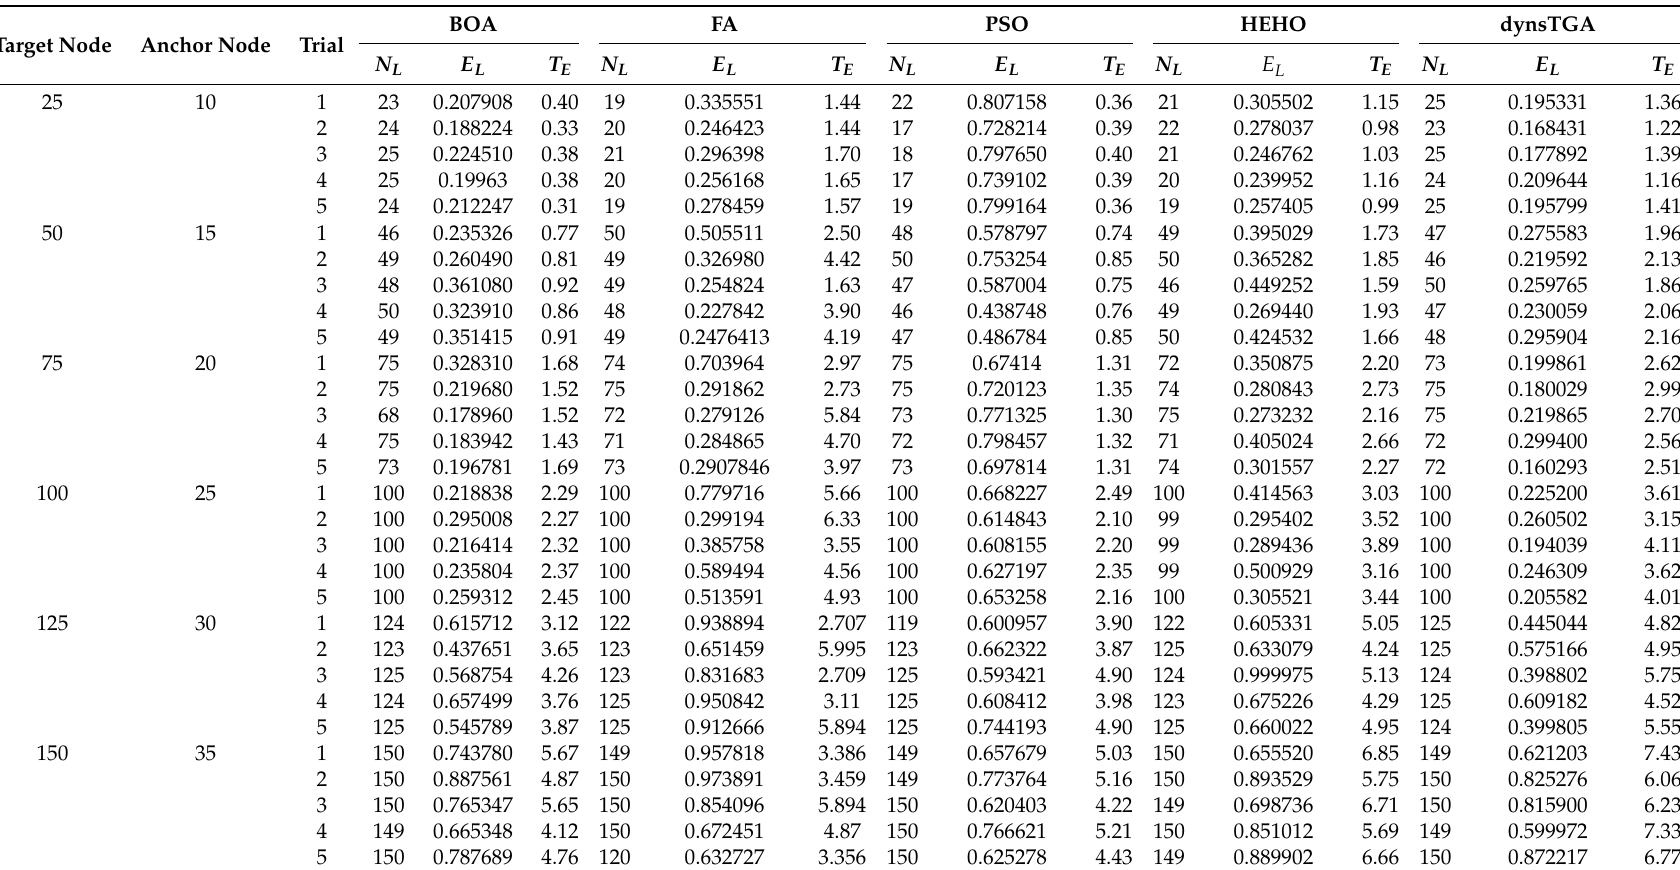
Table 8. Detailed results of BOA, FA, PSO, HEHO, and dynsTGA proposed localization—results for BOA, FA, and PSO were taken from [15] ( N L = number of localized nodes, E L = localization error, T E = execution time in